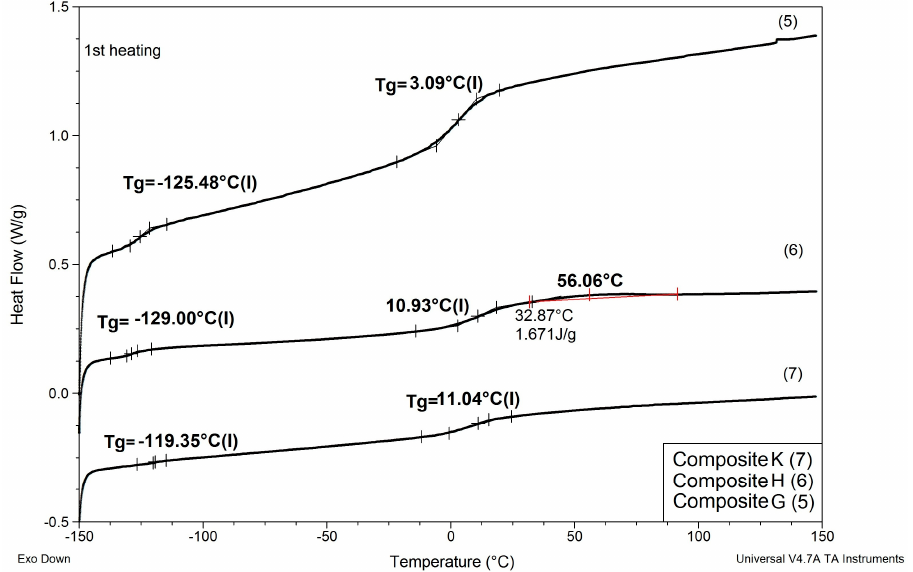
Figure 8. Comparison of DSC patterns obtained for composites G and H (prepared with reactive IL 3 and IL 4, respectively, replacing 20% of PSUR prepolymer), and composite K (prepared with reactive IL 3 replacing 80% of